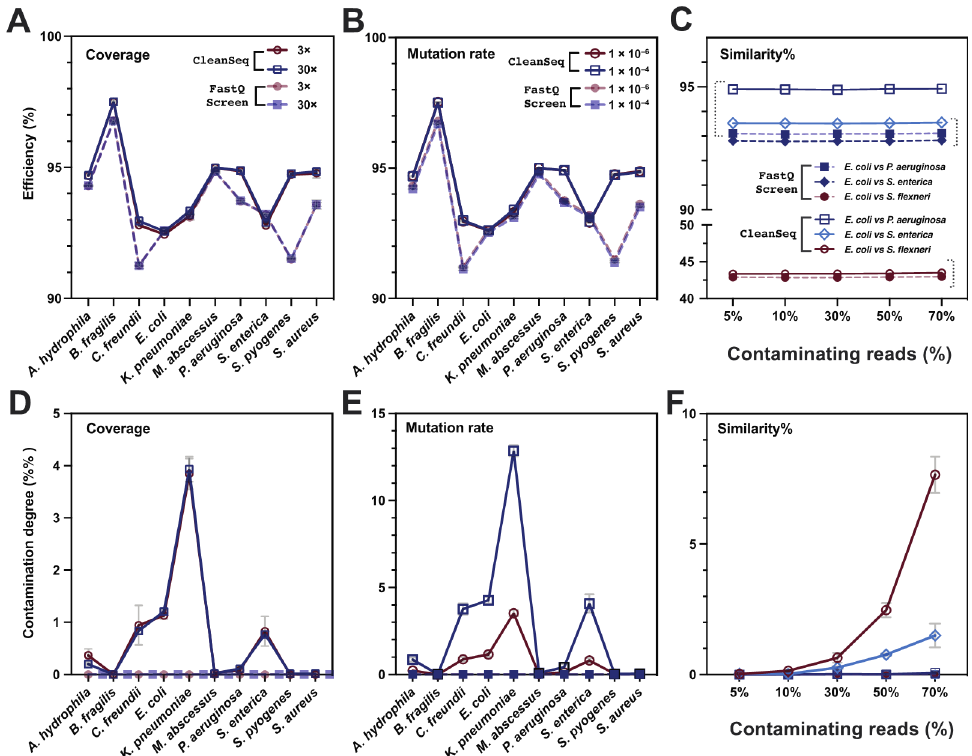
Figure 2. Comparison of the cleanup performance between CleanSeq and FastQ Screen. Employing a series of simulated datasets with various coverages (( A , D ), 3 × and 30 × ), mutation rates (( B , E ), 1 × 10 − 4 , 1 × 10 − 6 ), and genome similarities (( C , F ), 0.42% for E. coli and P. aeruginosa , 7.73% for E. coli and S. enterica , and 82.99% for E. coli and S. flexneri , with 30%~70% contamination rates). Two outcome values, efficiency and contamination degree after cleanup were calculated and compared to evaluate the overall performance. Efficiency refers to the ratio of clean reads in total reads. Contamination degree refers to the percentage of mutated reads in clean reads. The higher the cleaning efficiency and the lower the contamination degree, the better performance is indicated. The genome similarity between E. coli and P. aeruginosa , E. coli and S. enterica , and E. coli and S. flexner is low (0.42%), medium (7.73%), and high (82.99%), respectively.